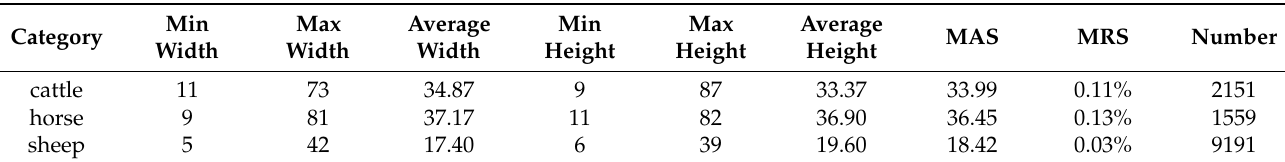
Table 2. Details of objects’ sizes in the dataset.